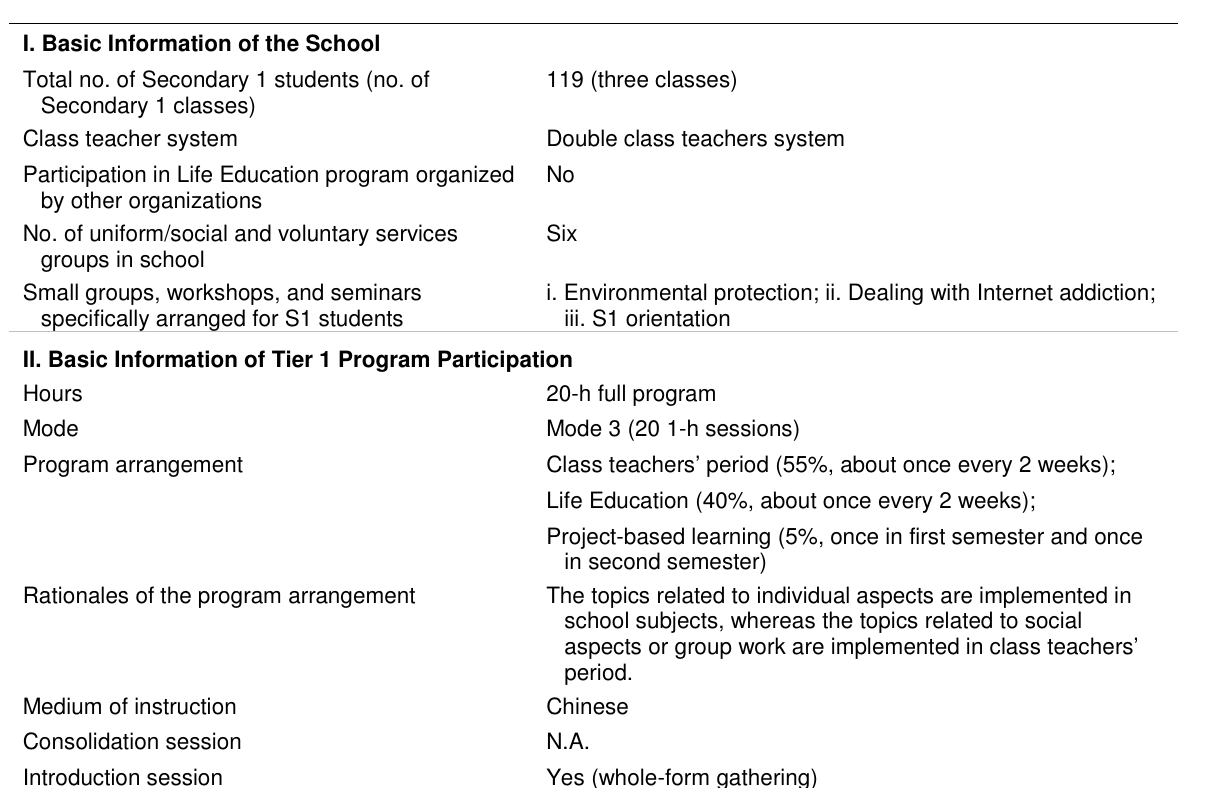
Summary of the Characteristics of the